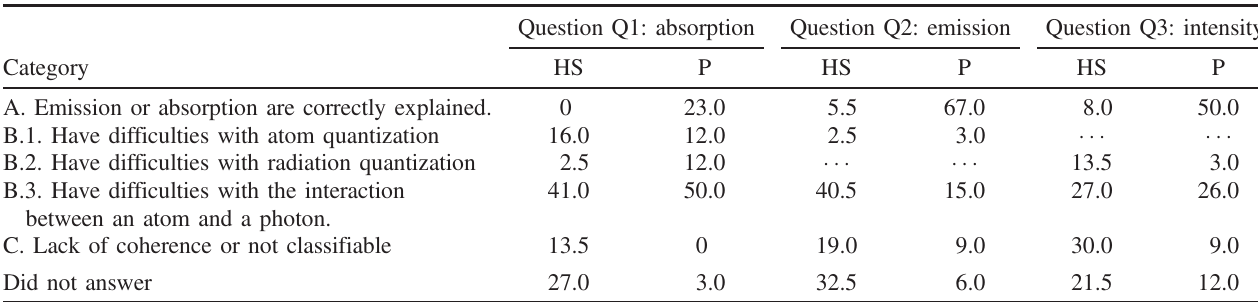
TABLE I. Percentage of answers given to the questions by 37 high school Students (HS) and 34 Physics Students (P). Question Q1: absorption Question Q2: emission Question Q3: intensity Category HS P HS P HS P A. Emission or absorption are correctly explained. B.3. Have difficulties with the interaction between an atom and a